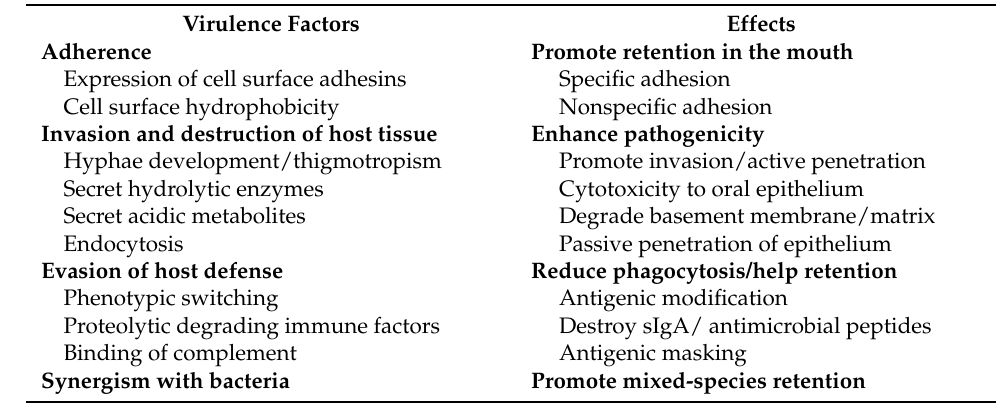
Table 2. Potential virulence factors of Candida